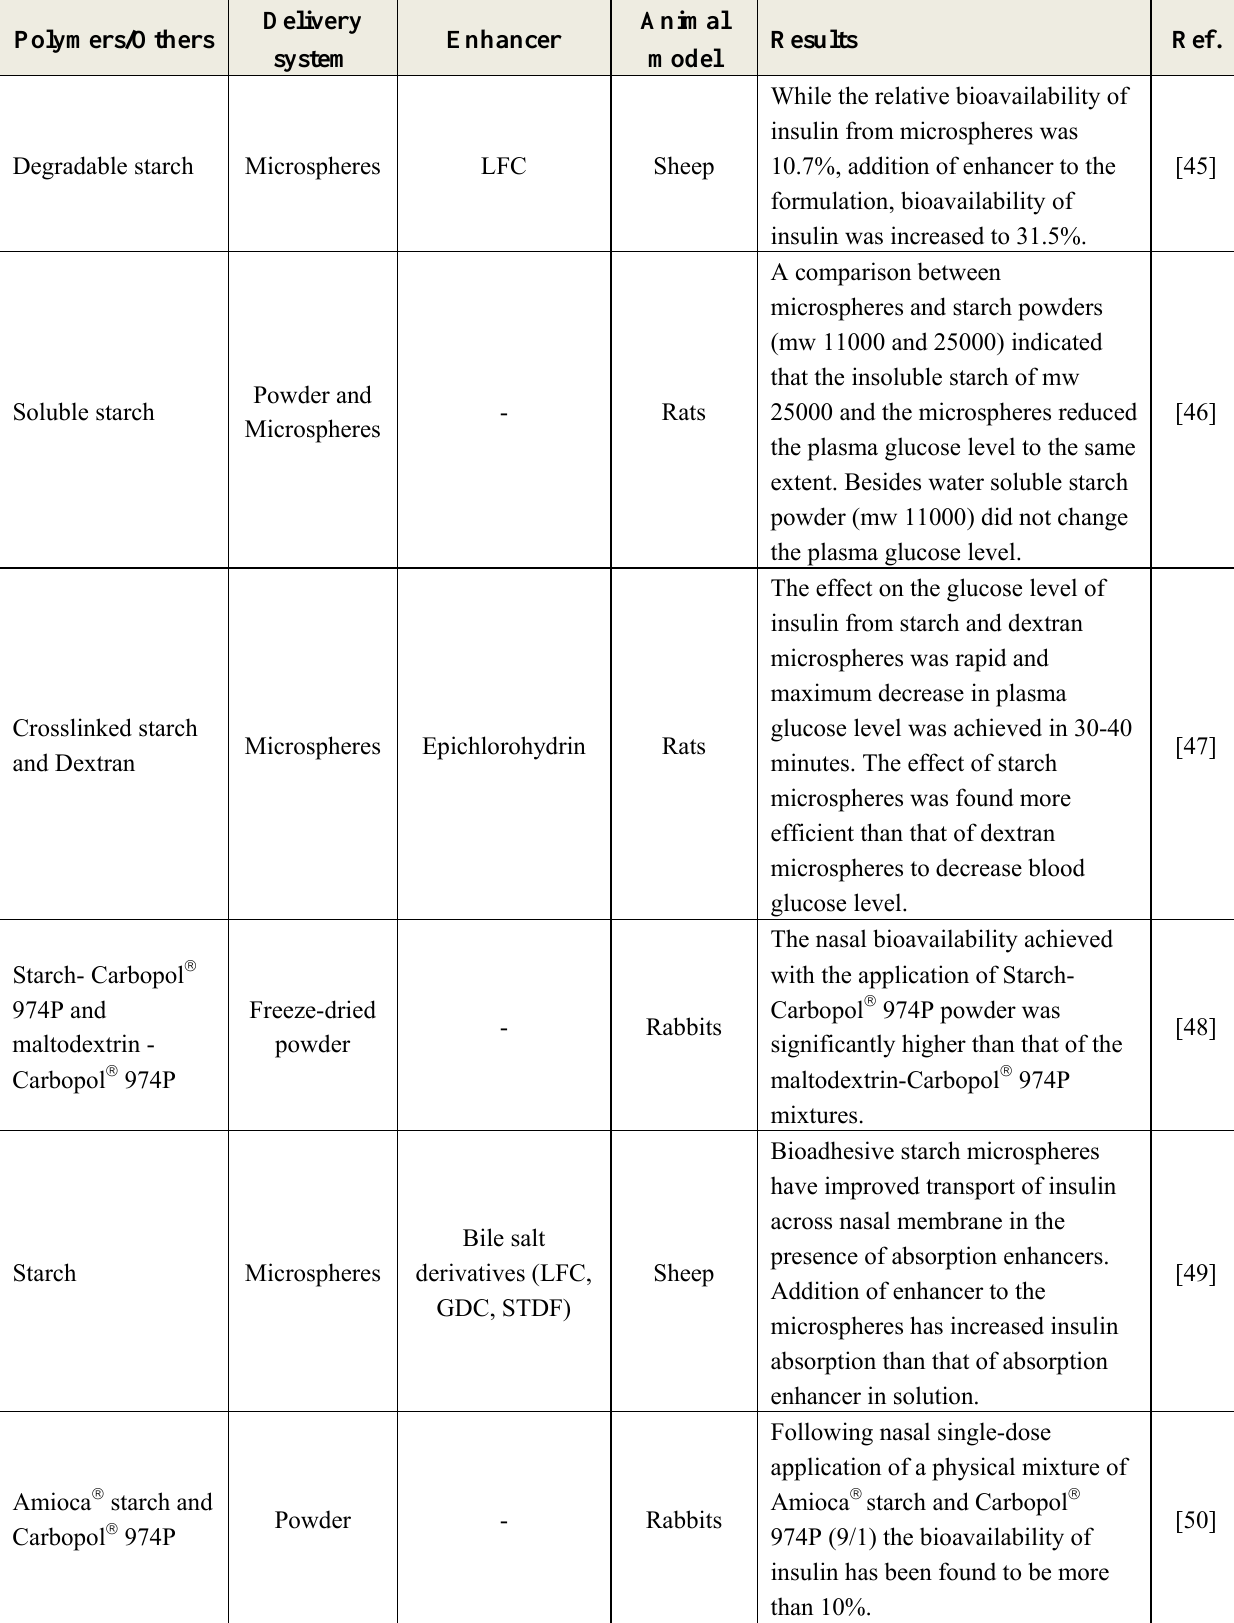
Table 2. Studies on nasal insulin